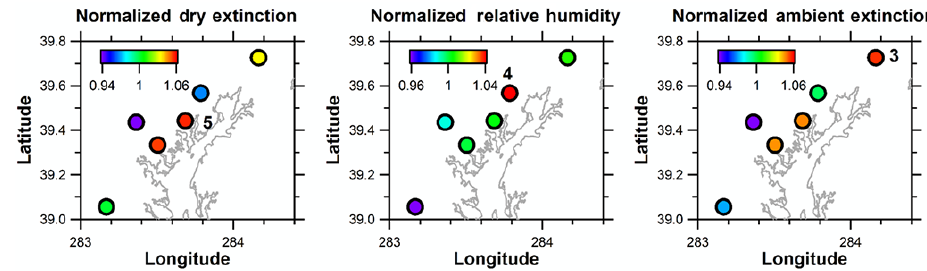
Figure 9. Average normalized 532nm dry extinction (left panel), RH (center), and 532nm ambient extinction (right) for all of the circuits (data are normalized to the average value for that circuit). The site with the maximum value is labelled.